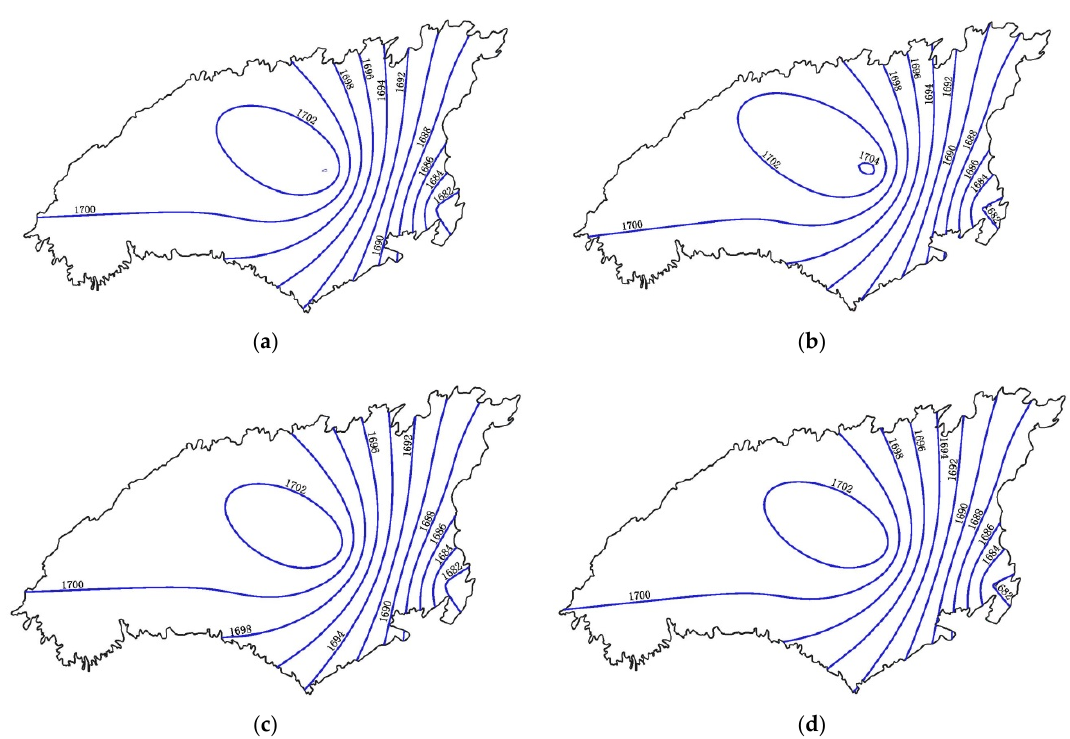
Figure 10. Changes of the groundwater level under different irrigation conditions (m): ( a ) the first year under the original irrigation amount; ( b ) the third year under the original irrigation amount; ( c ) the first year under 0.8 times the original irrigation amount; ( d ) the third year under 0.8 times the original irrigation amount.